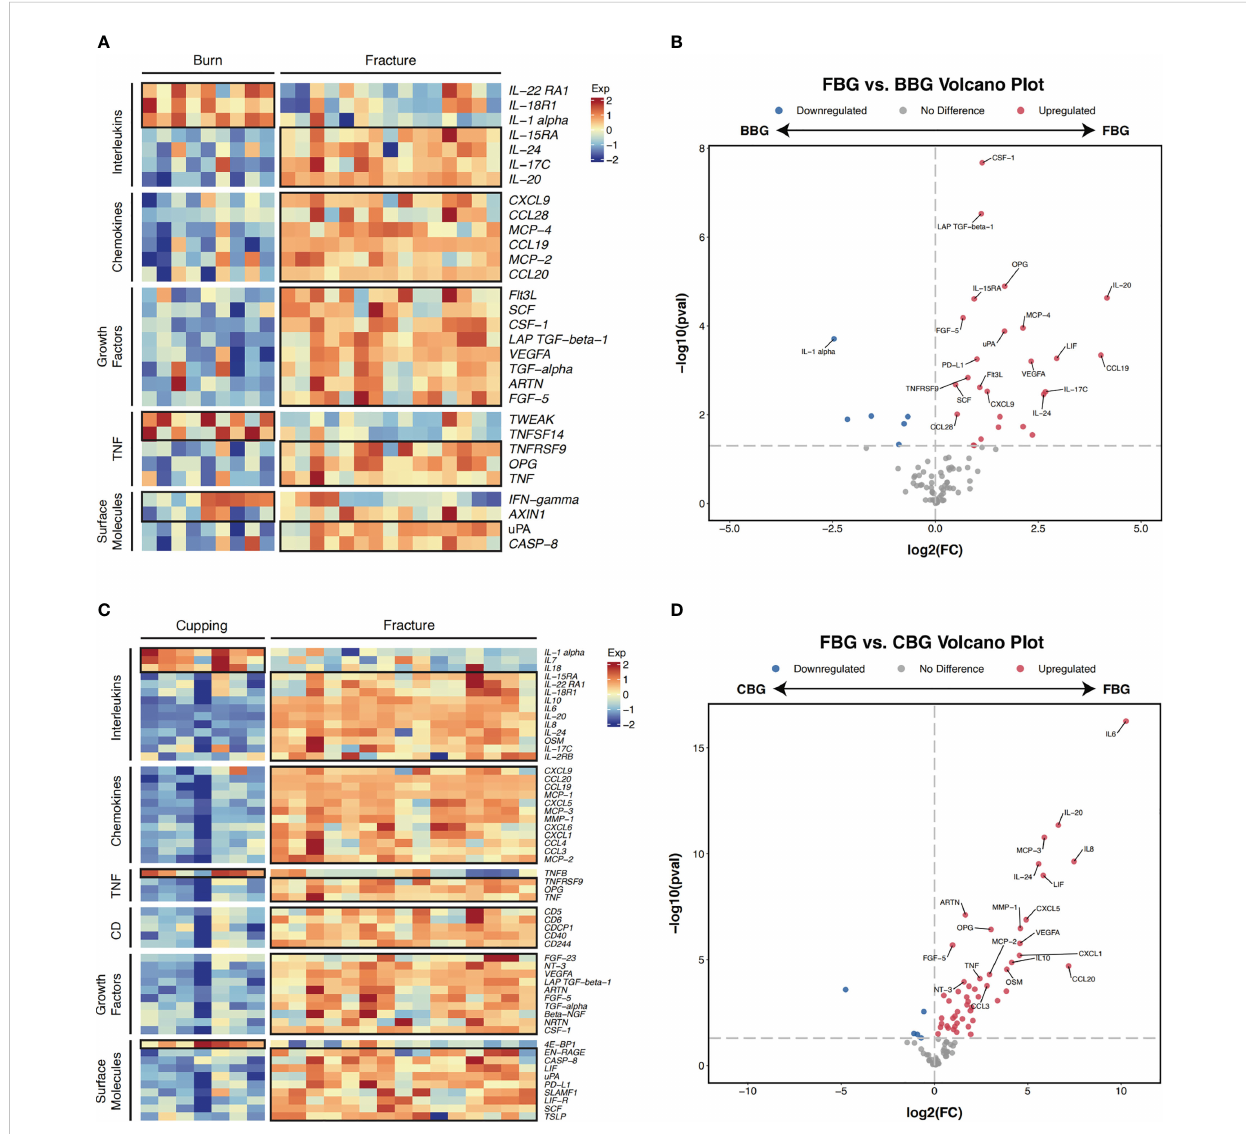
FIGURE 4 Pairwise comparison of differentially expressed genes. (A) Heatmap of differentially expressed proteins in FBG and BBG patients (P-value < 0.05). Proteins are manually annotated by protein family. (B) Volcano plot depicts differentially expressed genes between FBG and BBG patients. The gray dashed line indicates an exploratory cutoff of P-value < 0.05. Each red dot corresponds with a gene passing the exploratory cutoff. Genes of interest are marked with gene names. (C) Heatmap of differentially expressed proteins in FBG and CBG patients (P-value < 0.05). Proteins are manually annotated by protein family. (D) Volcano plot depicts differentially expressed genes between FBG and CBG patients. The gray dashed line indicates an exploratory cutoff of P-value < 0.05. Each red dot corresponds with a gene passing the exploratory cutoff. Genes of interest are marked with gene